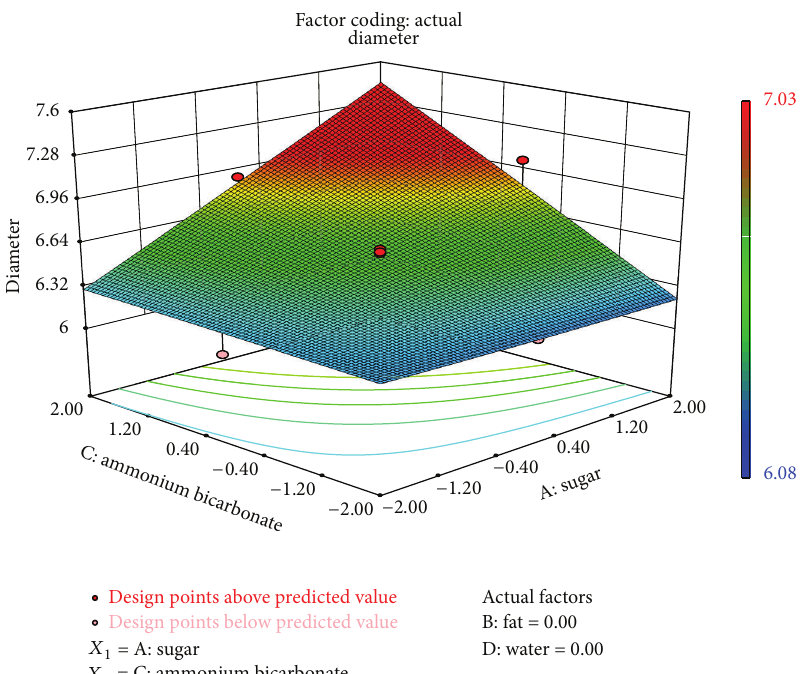
Figure 1: Surface plot representing the effect of sugar ( 𝑋 1 ) and ammonium bicarbonate ( 𝑋 3 ) on diameter of the biscuits.